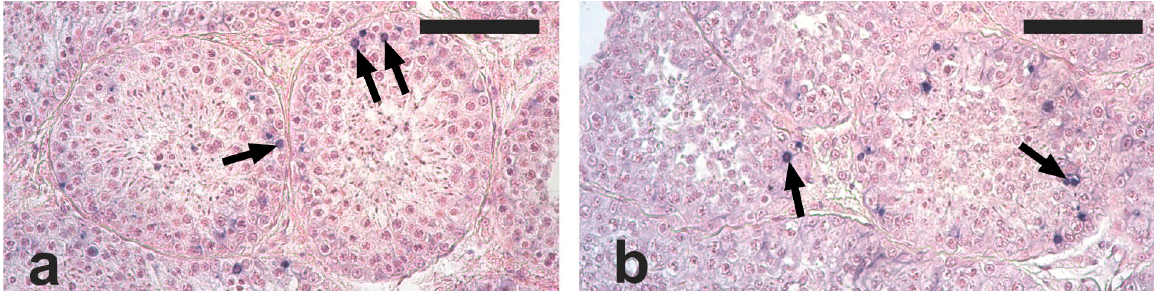
Figure 2. Micrographs of testis sections from cats orchiectomized during the reproductive ( a ) and non-reproductive ( b ) seasons stained with the terminal deoxynucleotidyl transferase-mediated d’UTP nick end labeling (TUNEL) method and counterstained with Fast Red. Apoptotic cells and apoptotic bodies (arrows) are visible within the tubular compartment as blue spots. Scale bars = 100 μ m.